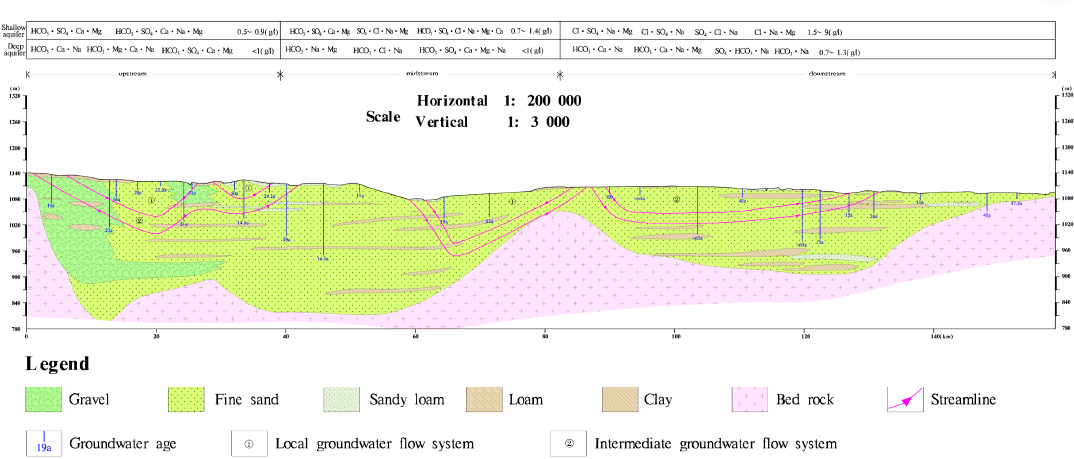
Figure 6. Hydrogeological structure and surface–GW interaction model in Profile 3.